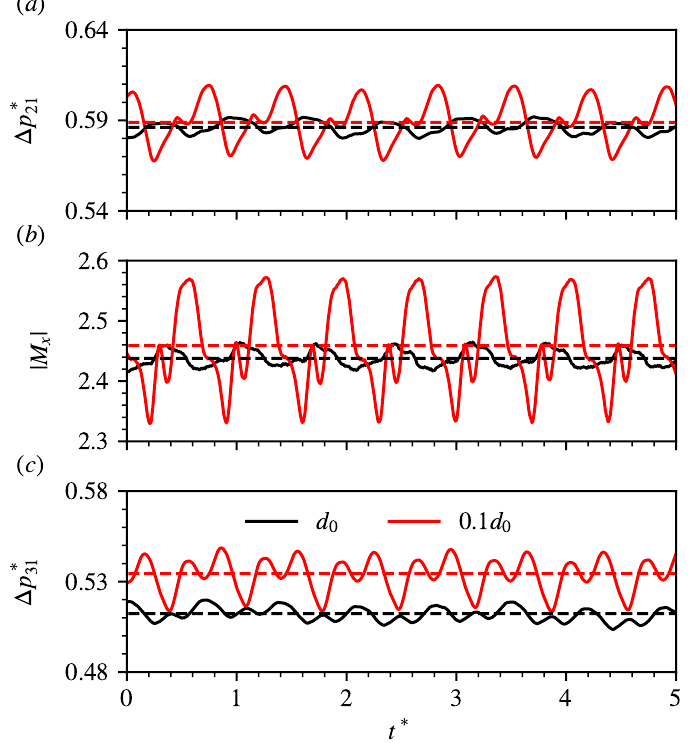
Figure 13. Time profiles of ( a ) the total pressure rise coefficient on the rotor outlet, ( b ) the aerodynamic moment on the rotor blade and ( c ) the total pressure rise coefficient on the stator